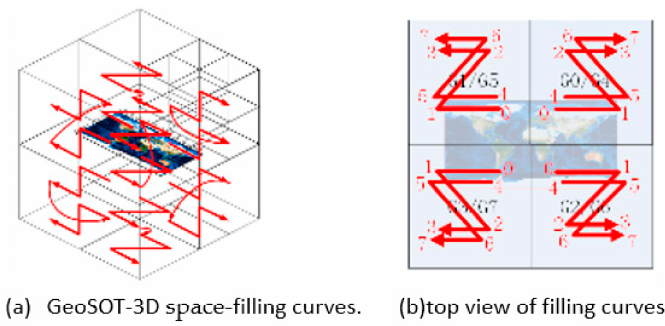
Figure 6. GeoSOT-3D space-filling curves.